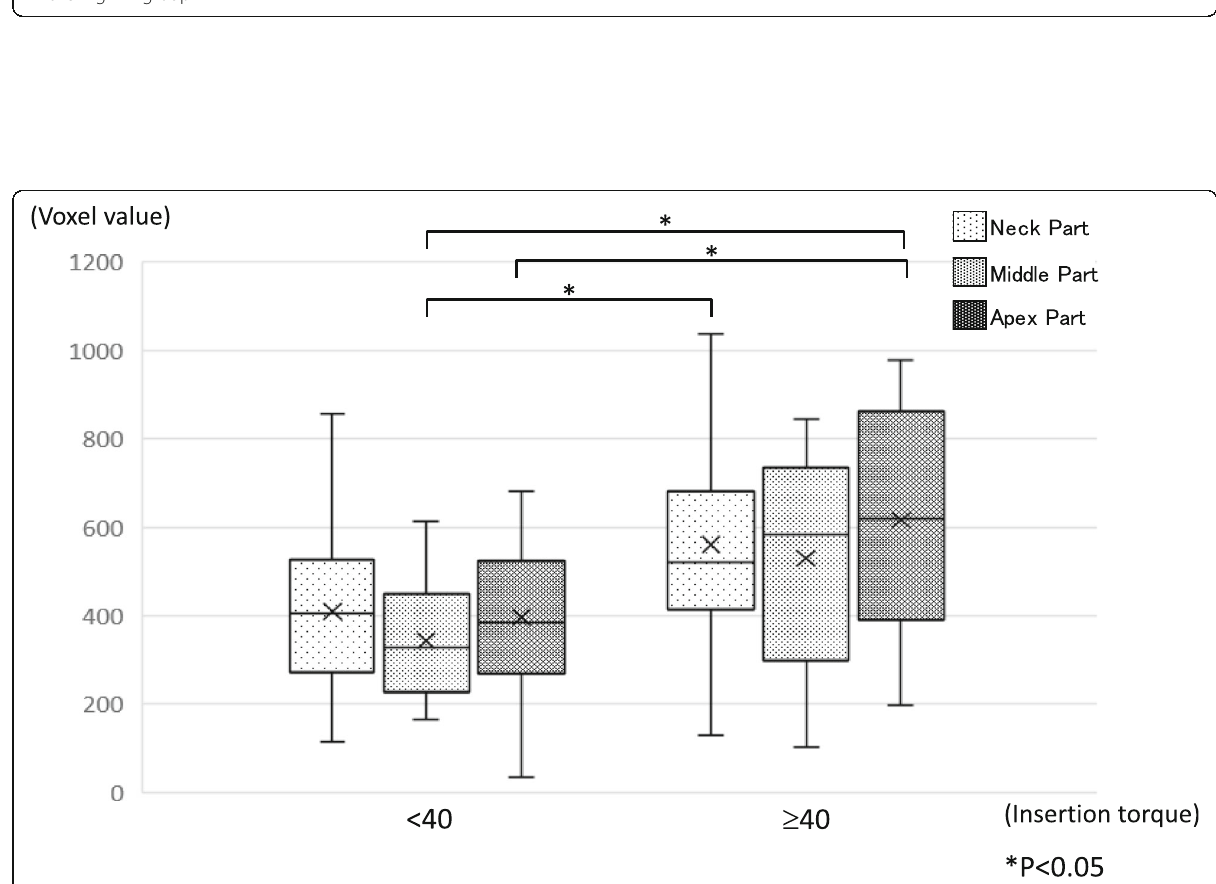
Fig. 9 The comparison of two groups at average voxel values for each part. The comparison of voxel values by insertion torque. All specimens were classified into two groups by insertion torque < 40 and ≥ 40. The < 40 group represents a combination of the low and medium IT